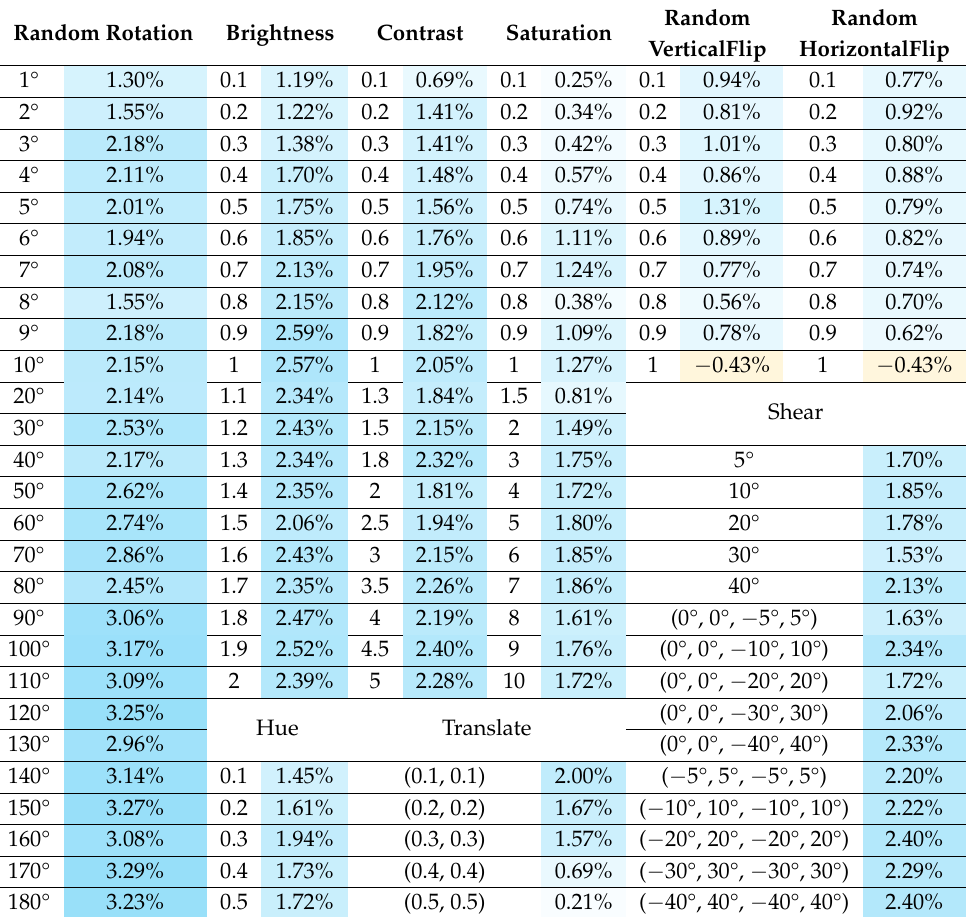
Table 5. Performance of DA methods on Γ train 200 . The DA methods and parameters impact on Γ train 200 PAP PAP classification performance is shown. The displayed percentage values describe the increase/decrease of mAA in percent. The value is color-coded from blue (increase in accuracy) over white (no effect) to orange (decrease in